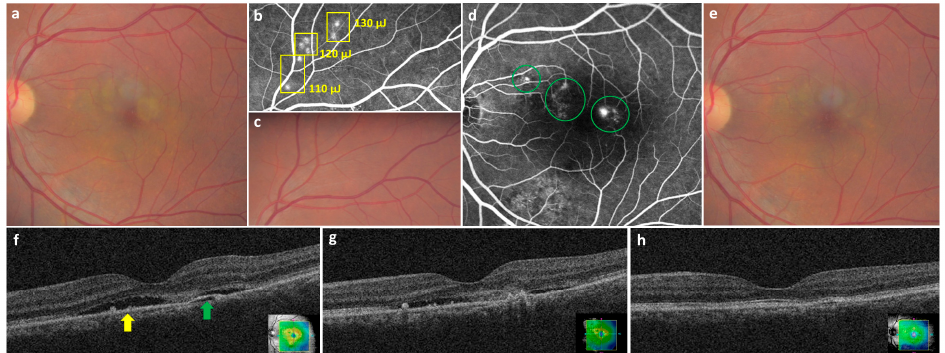
Figure 1. Representative pictures of the selective retinal therapy (SRT) procedure in the left eye of a 49-year-old man. He presented with a 12-months history of blurred vision in the left eye. His best-corrected visual acuity (BCVA) in the left eye was 20/32. ( a ) At baseline, subretinal fluid (SRF) was observed on color fundus photography (CFP). ( b ) Seven hyperfluorescent test spots (110–130 µ J) (yellow rectangle) were observed around the superior temporal vessels on fundus fluorescein angiography (FFA) 1 h after irradiation. ( c ) The 7 test spots were invisible on CFP 1 h after irradiation. ( d ) Thirty-one SRT spots were applied at multiple leaking points (green circles) on FFA. ( e ) No visible SRT spot was seen 6 months post-treatment ( f ) SRF (yellow arrow) with pigment epithelial detachment (green arrow) was observed on baseline optical coherence tomography (OCT). ( g ) Since SRF persisted on OCT images obtained 3 months after SRT, retreatment was performed. ( h ) SRF was completely resolved on OCT images obtained at 6 months post-treatment, and BCVA had improved to 20/25.